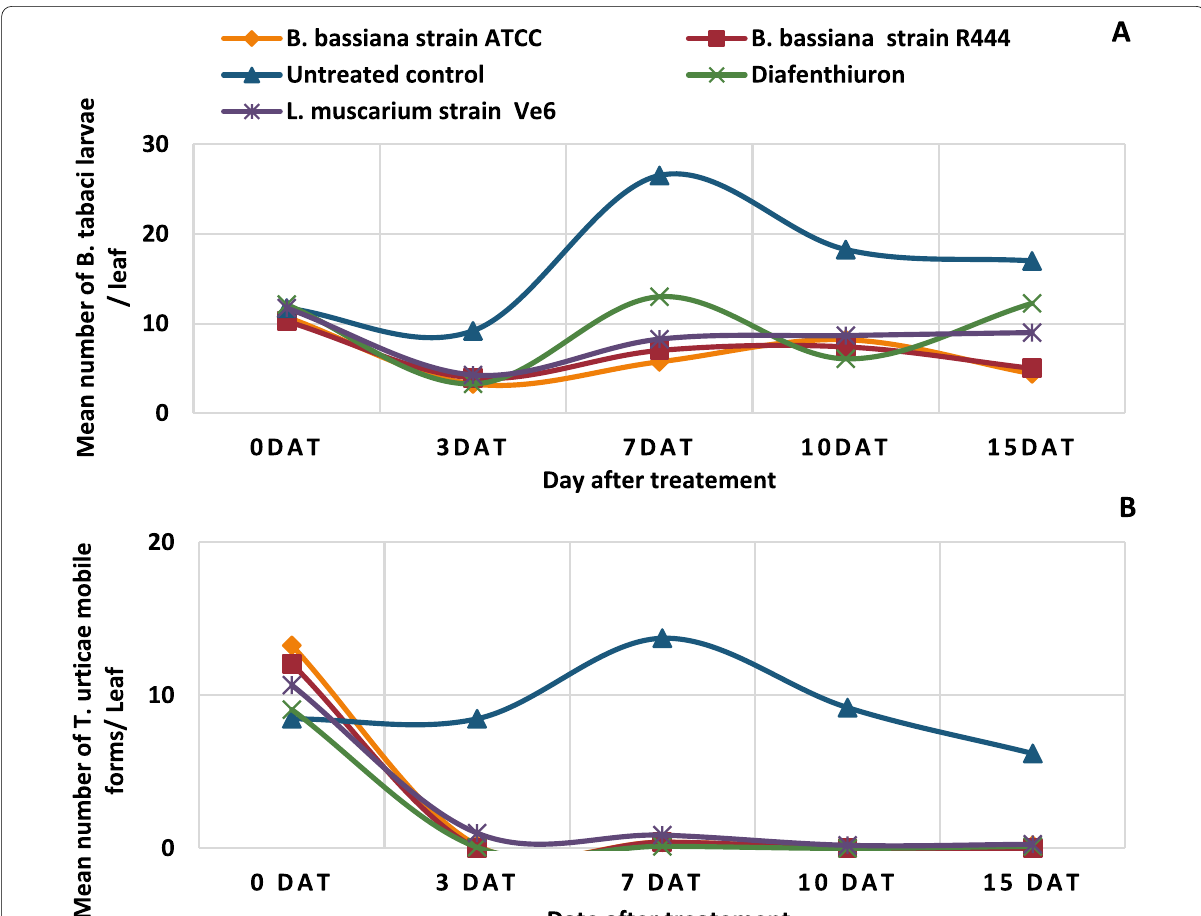
Fig. 3 Mean number of Bemisia tabaci larvae and Tetranychus urticae mobile forms as a function of treatment with entomopathogenic fungi for 15 days ( A : Bemisia tabaci larvae, B : Tetranychus urticae mobile